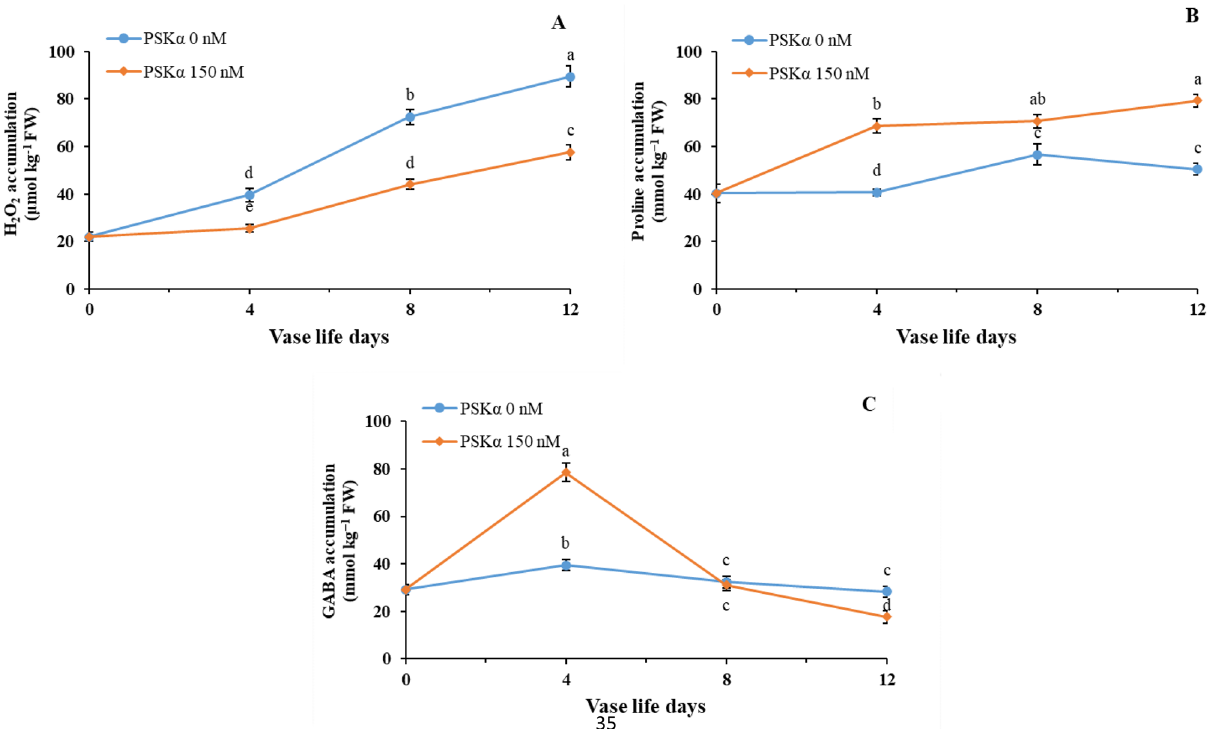
Figure 3. Endogenous H 2 O 2 ( A ), proline ( B ) and GABA ( C ) accumulation in petals of rose flowers treated with PSKα at 0 and 150 nM during vase life at 20 °C for 12 days. Data shown are mean values of n = 3, and the error bars represent standard errors of the means. Mean values followed by different letters indicate they are different by LSD test at P < 0.05.